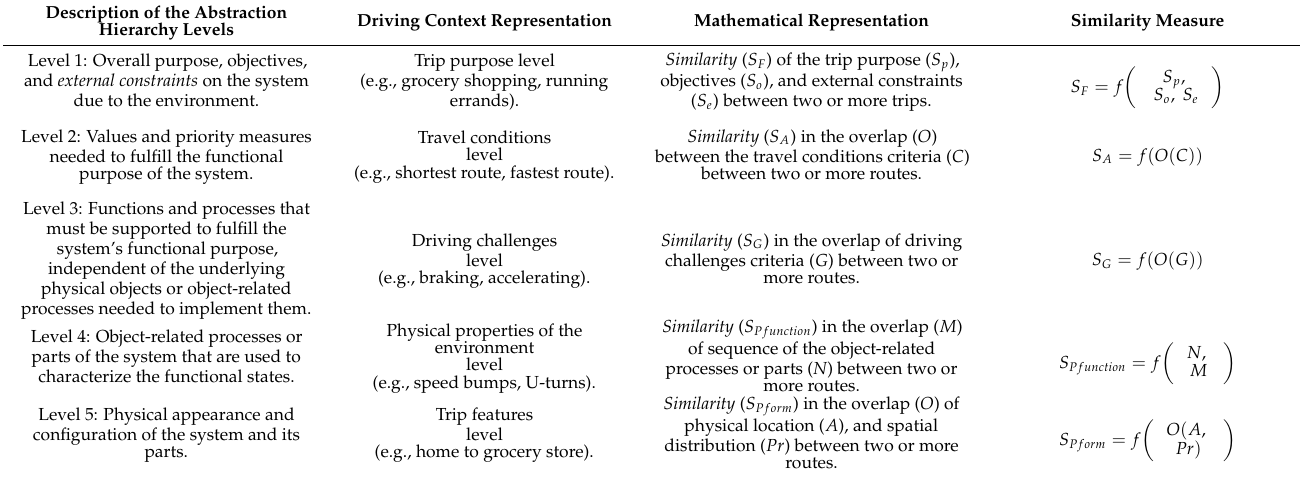
Table 7. Proposed mathematical representation of each of the abstraction hierarchy levels describing route familiarity. Description of the Abstraction Hierarchy